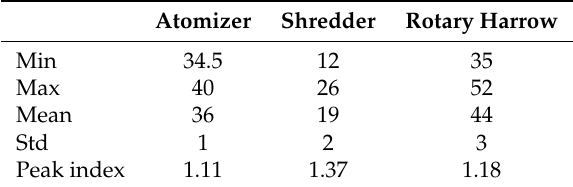
Figure 7. Performance comparison: model vs. experimental data. Table 4. Statistics of the considered PTO working scenario—Power